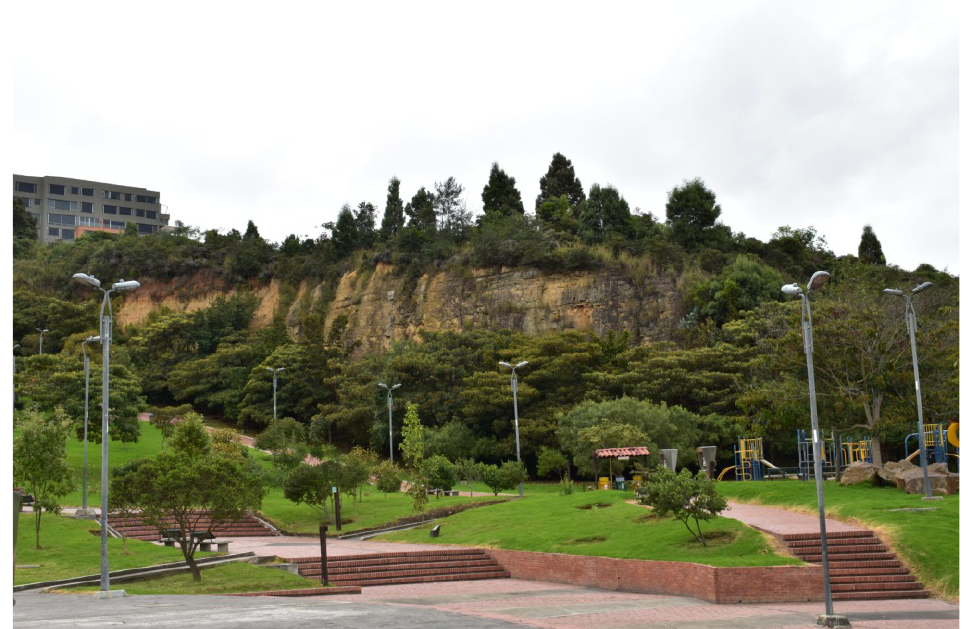
Figure 1. Los Nevados Park, June 2017. This sacred place for the Muisca community is under the administration of the government of the district. While it is a public park, there is a group of Muisca families— raizales (traditional inhabitants) who remain living in the